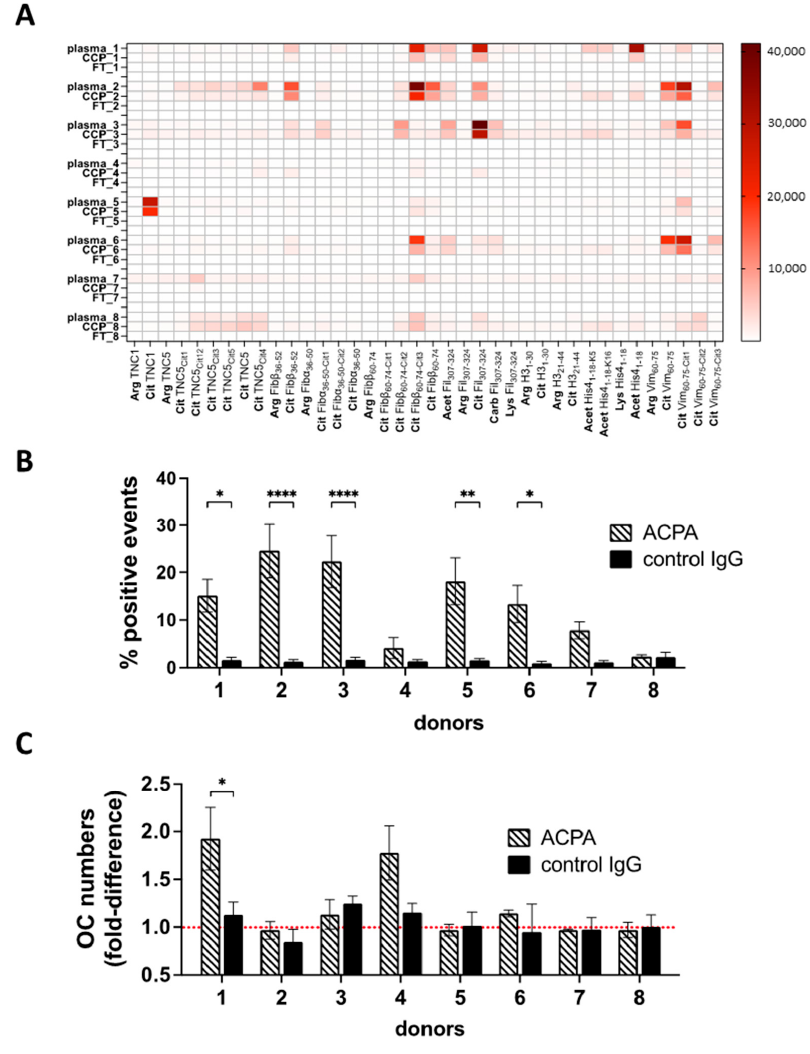
Figure 5. Individual variability in ACPA cellular targets. ACPAs were purified from plasma samples obtained from eight individual RA patients. Fine-specificity patterns of the original plasma samples, ACPAs purified with CCP affinity chromatography and the ACPA-depleted IgG fractions (flowthrough, FT) were studied using a multiplex solid-phase peptide array platform ( A ). Peripheral blood neutrophils were activated with A23187 for 45 min, then fixed and permeabilized and stained with the different ACPA or the corresponding control (ACPA-depleted) IgG preparations ( B ). The same antibodies were also added to cultures of developing OCs. Osteoclast numbers were normalized to control samples cultured without antibodies; average values were calculated from three independent experiments ( C ). **** p < 0.0001, ** p < 0.01, * p < 0.05